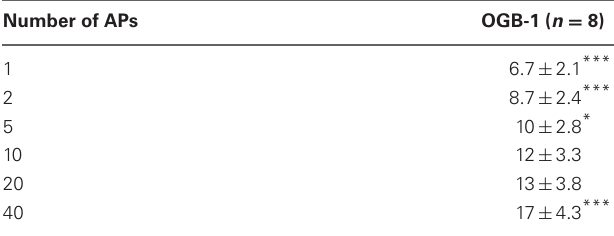
Table 4 | SNR of OGB-1 in cortical layer 2/3 pyramidal